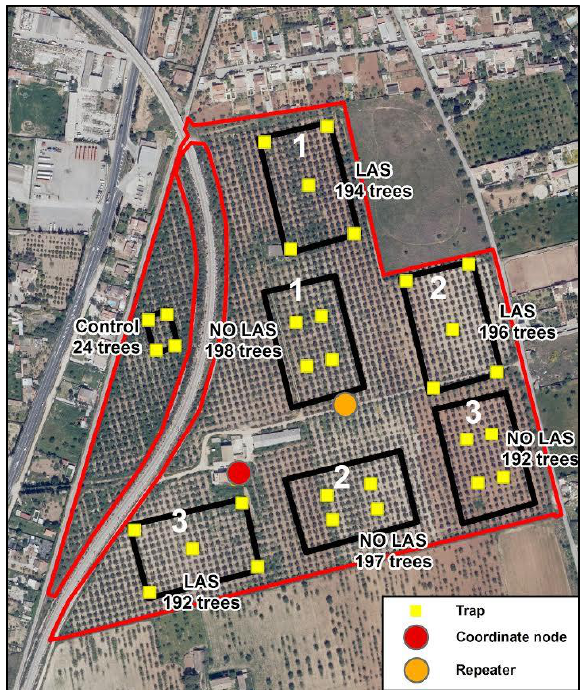
Figure 1. Area of study in Son Llompart: Location aware system (LAS) plots 1, 2, and 3 (where decision support system (DSS) was applied); NO-LAS Plots 1, 2, and 3 (conventional control) and control plot are represented.